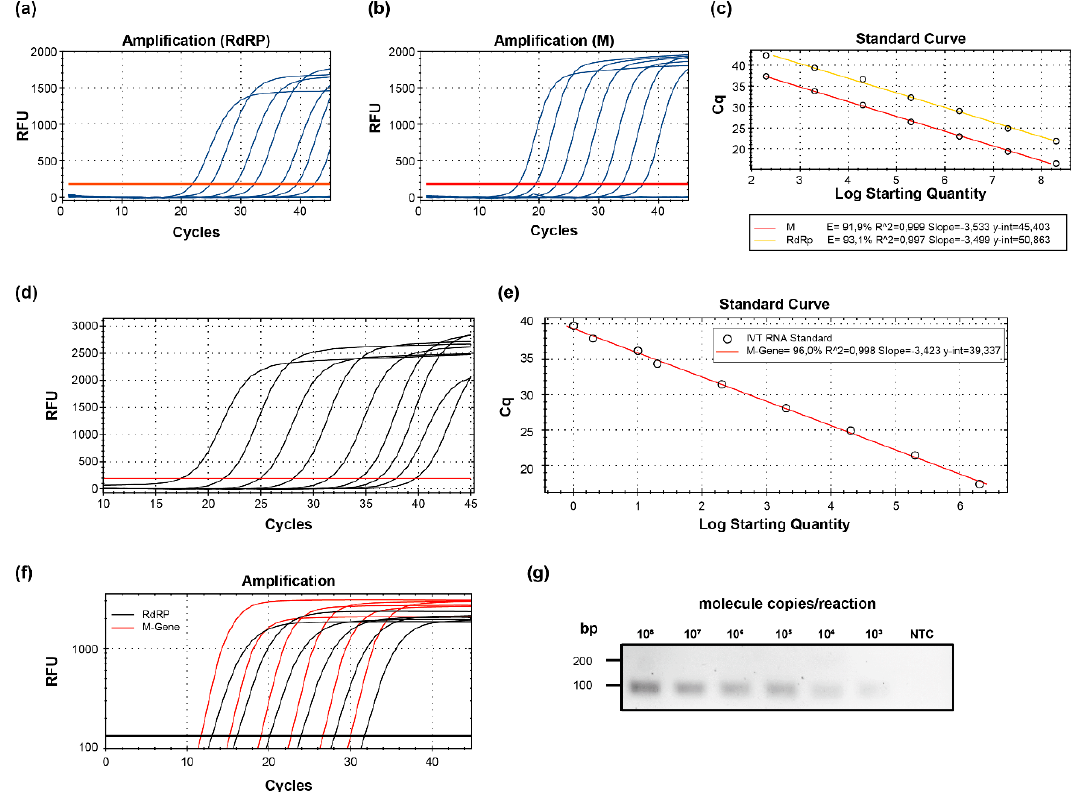
Figure 2. Characteristics of M-gene based qRT-PCR. ( a ) Representative amplification curves of WHO RdRP- and ( b ) SARS-CoV-2 M-gene-specific qRT-PCR using plasmid standard copy numbers. ( c ) Standard curves of both genes determined with plasmid templates. The Cq was plotted against the log starting quantity of the indicated plasmid DNA template. ( d ) Representative amplification curves and ( e ) standard curves of SARS-CoV-2 M-gene-specific qRT-PCR using in vitro-transcribed RNA templates. Log starting quantity (copies/reaction) is indicated and plotted against the Cq. ( f ) Representative amplification curves for SARS-CoV-2 M- and RdRP-gene-specific qRT-PCR using in vitro-transcribed RNA templates harboring both target sequences. ( g ) Distinct M-gene amplicons visualized in a 2% agarose gel. The RNA copy numbers per reaction are indicated on the top. RFU, relative fluorescence units; bp, base pairs; Cq, quantification cycle; NTC, no template control (H 2 O); E, amplification efficiency.